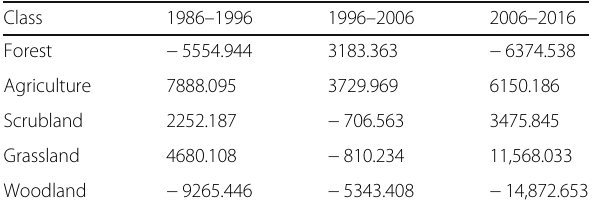
Table 4 Landscape rate of change in Bale eco-region